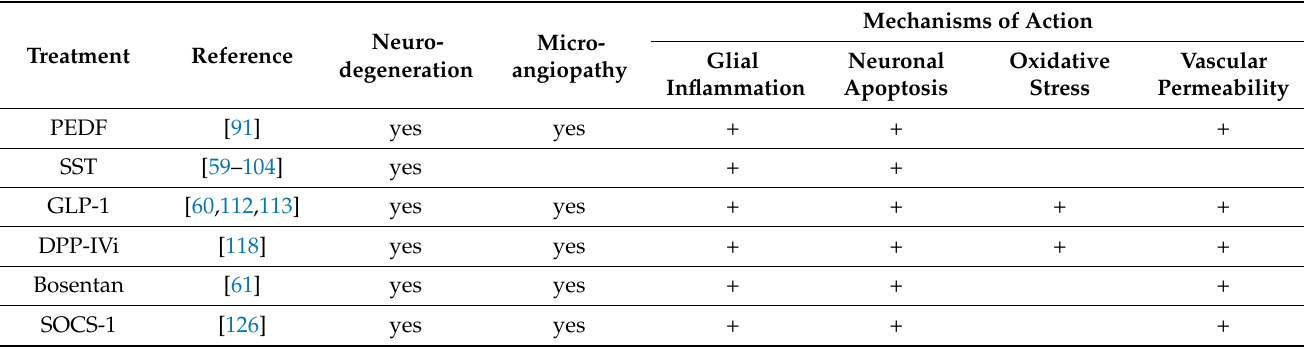
Table 1. Main mechanisms of action of the most representative topical treatments (eye drops) for early stages of DR in experimental